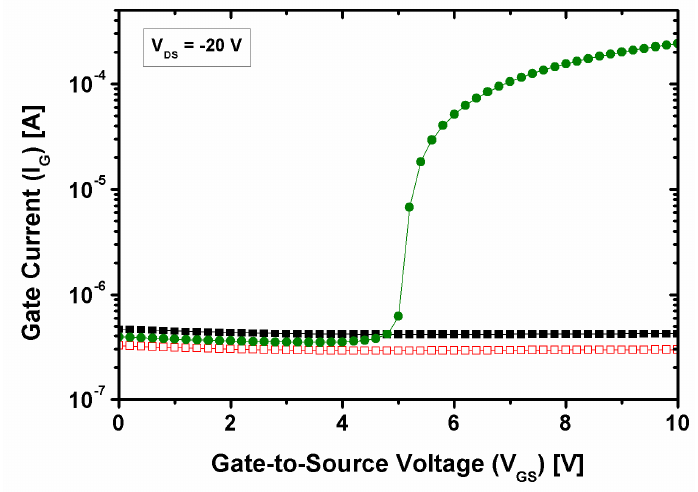
Figure 9. Measured Gate current as a function of the Gate bias ( I G vs. V GS at V DS = − 20 V) for several V-JFET samples with equal design, fabricated on the same wafer. The leakage current increase for V GS > V OFF , observed in one malfunctioning sample is compared with the curves of other prototypes with standard performance.